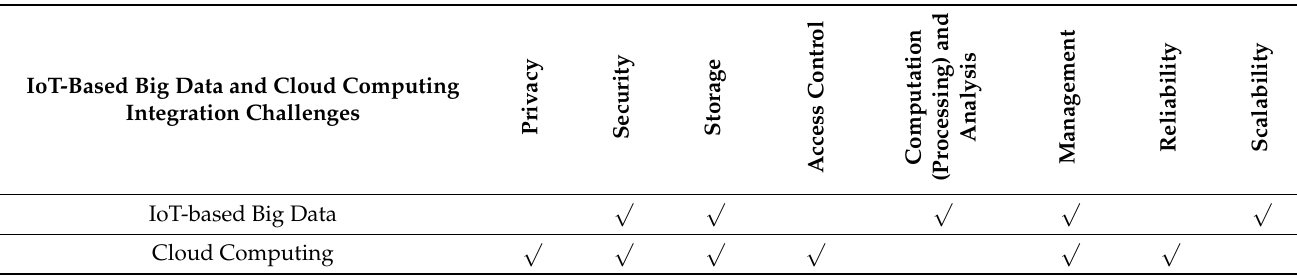
Table 4. Integration challenges of IoT-based Big Data and Cloud Computing.